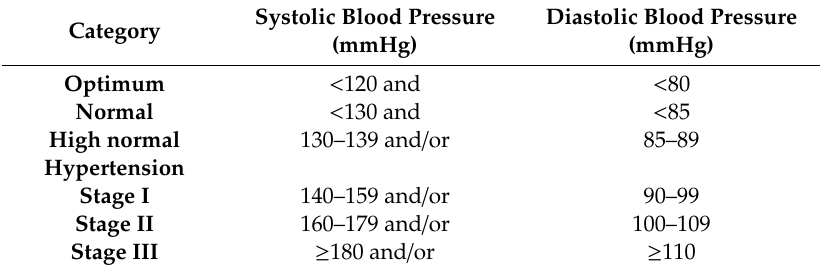
Table 1. Classification of blood pressure for adults aged 18 years and